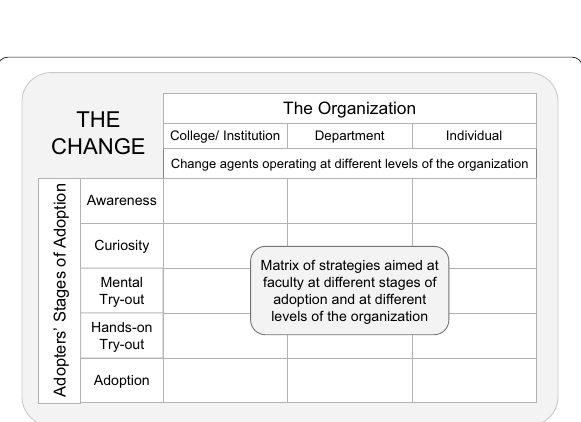
Fig. 6 A matrix for applying the CACAO model to change in higher education